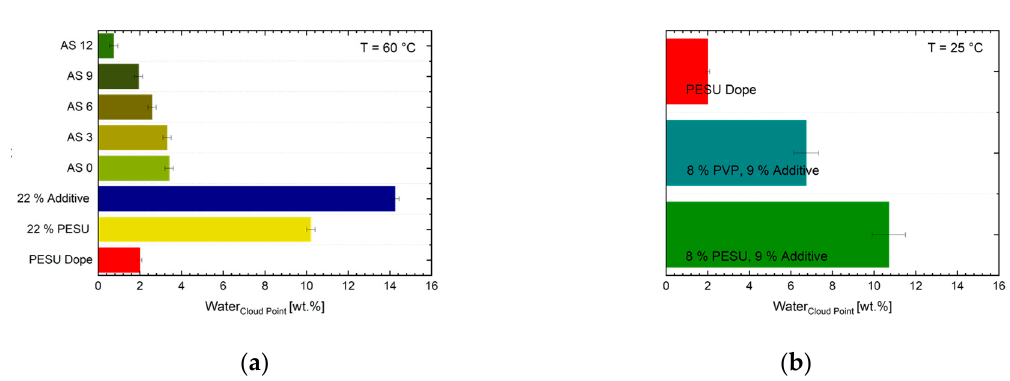
Figure 10. ( a ) Results of cloud point measurements for AS 0-12 and pure additive and PESU in NMP (both 22%) as well as the PESU standard solution, measured at 60 °C. In ( b ) the CP for PESU (8%) with additive (9%) and PVP (8%) with additive in NMP, as well as the PESU dope solution at 25 °C are compared. All CP display the mean value of three measurements for each sample.